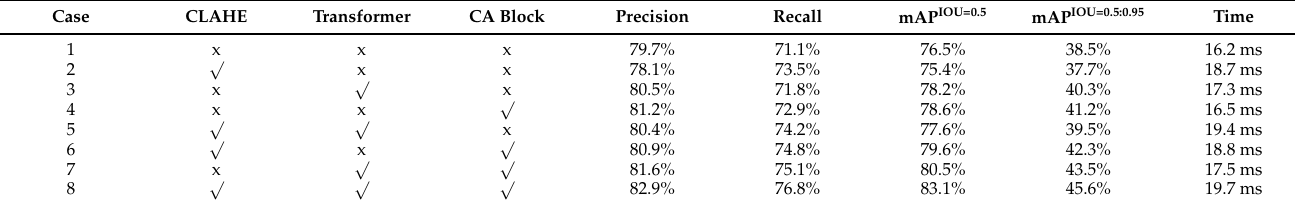
Table 3. Results of ablation